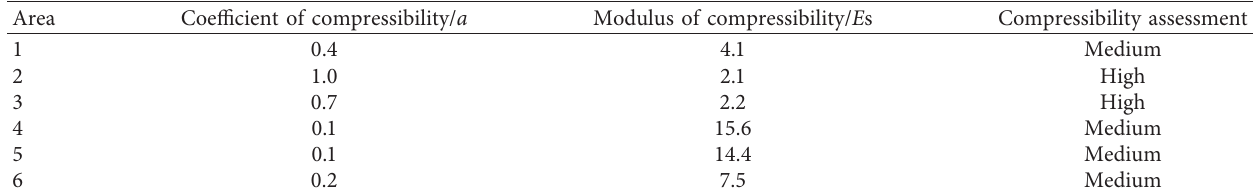
Table 8: Coefficient and modulus of the compressibility results.